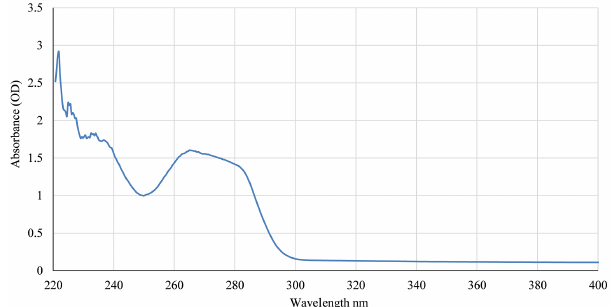
Figure 4. Bisphenol A UV–VIS absorbance spectrum in water (OD: optical